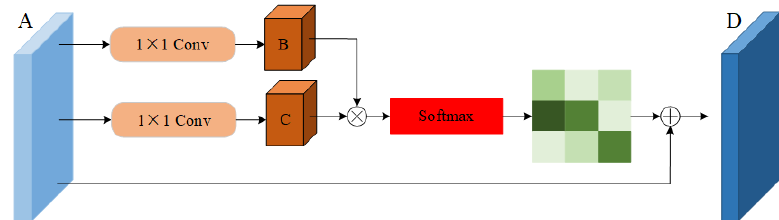
Figure 6. Importance attention module